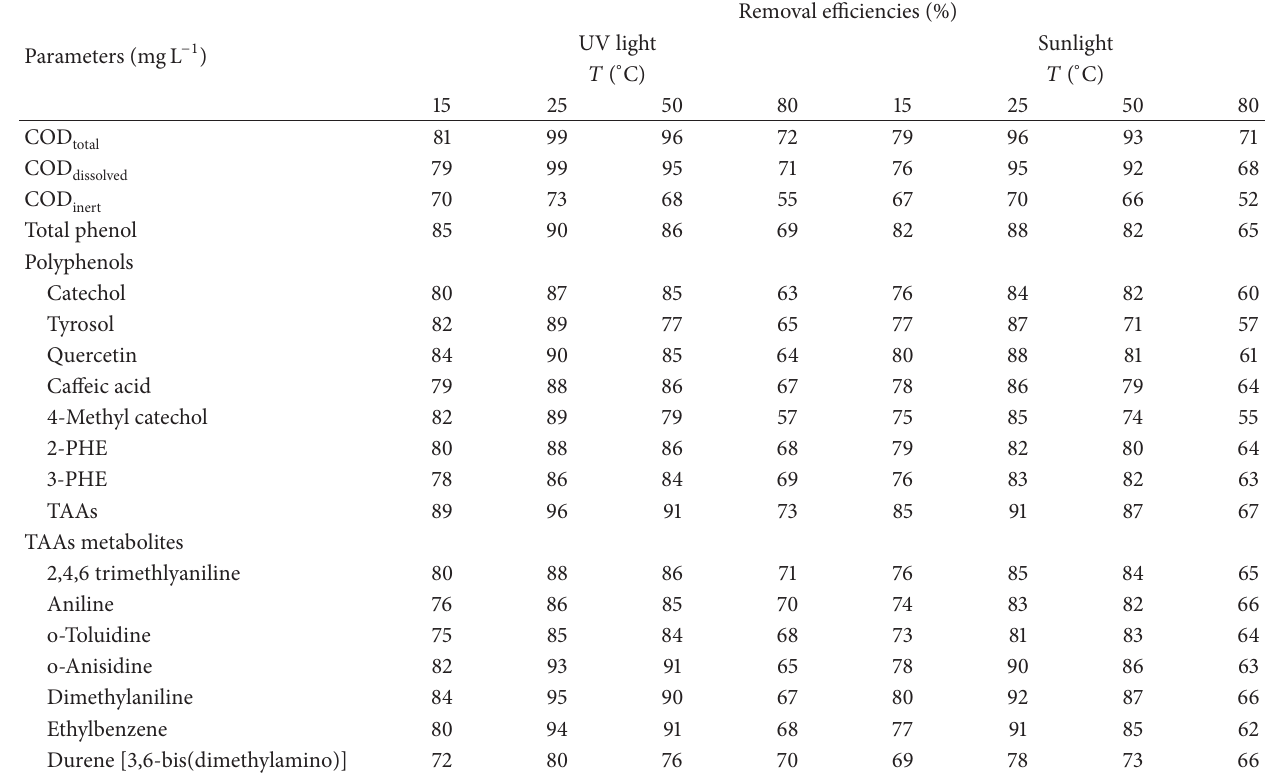
Table 4: Effect of increasing temperature values on the removals of OMW during photocatalytic degradation, at 500 mgL − 1 C/TiO nanocomposites, under 300 W UV and 30 W sunlight irradiations, after 60min, at pH = 7.0. ( 𝑛 = 3, mean values).